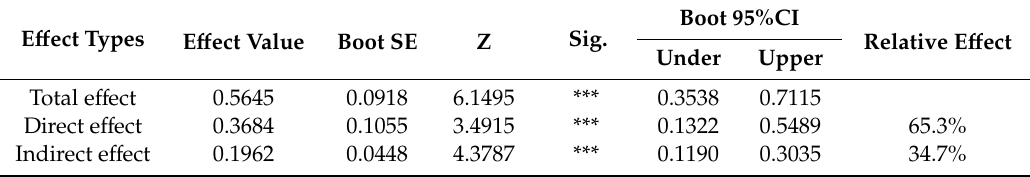
Table 6. The standardized direct, indirect, and total effects of social safety capital on safety citizenship behavior (SCB).